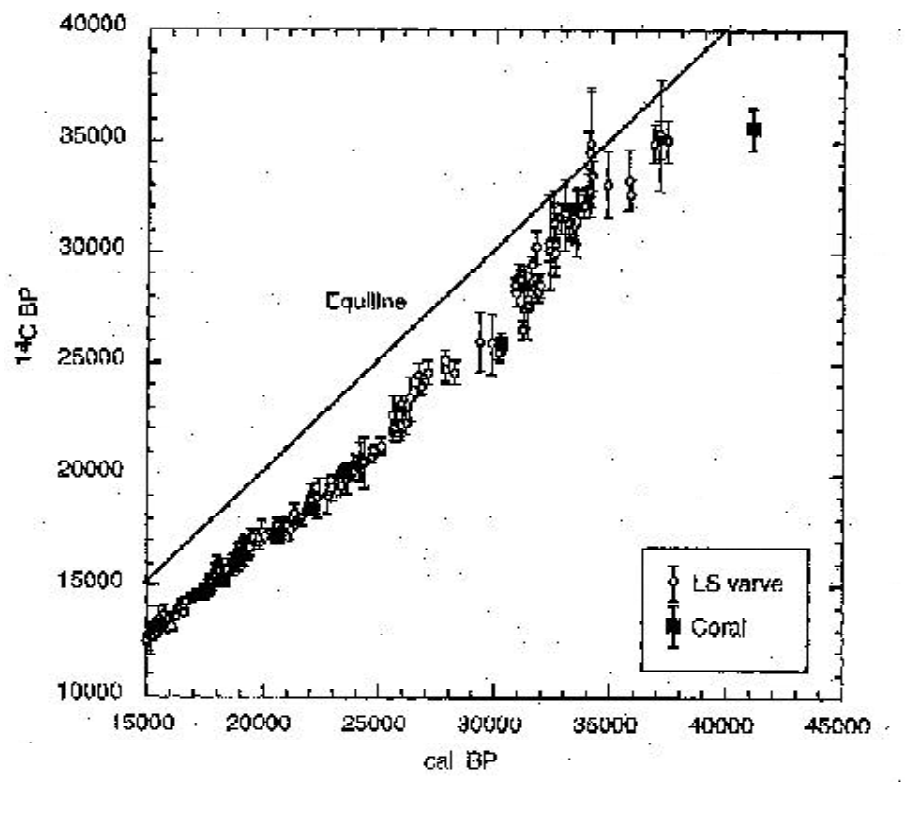
FIGURE 3. Extension of the radiocarbon calibration curve compiled from recent publications by Kitagawa and van der Plicht[19] and Beck et al.[14] These results show extensions to the calibration from U-Th in corals and speleothems, as well as lacustrine